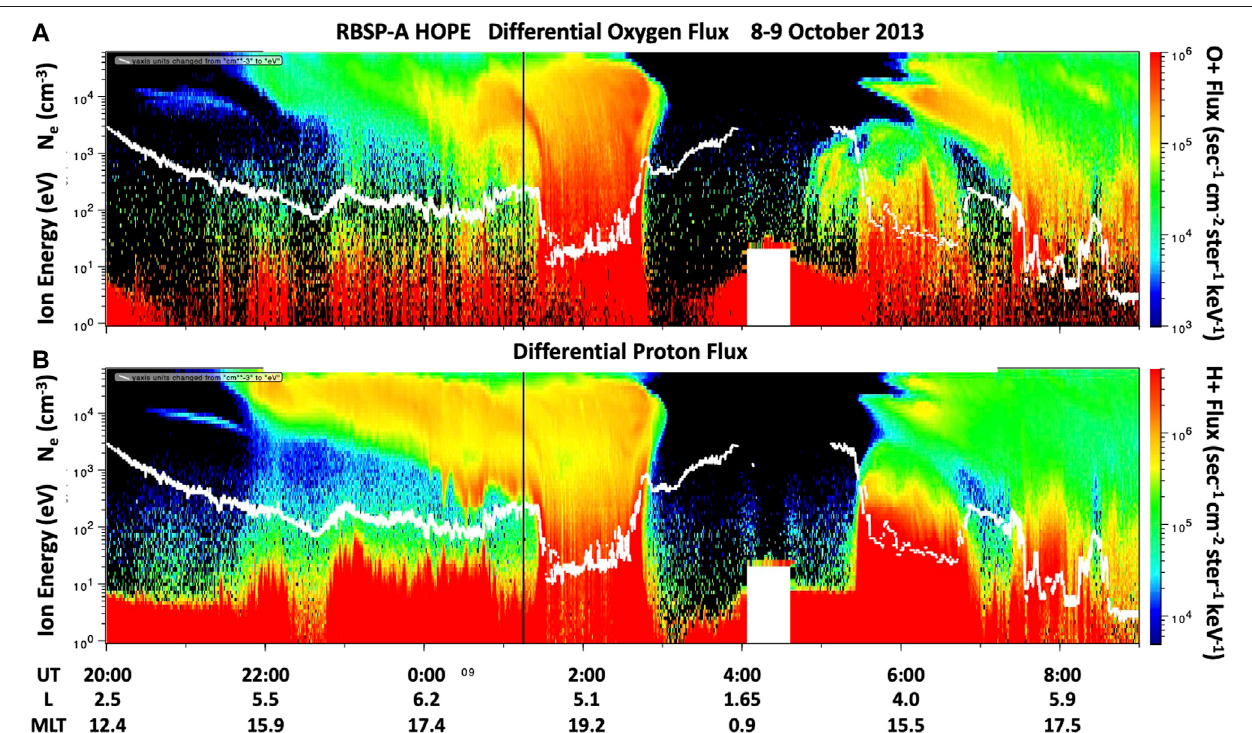
FIGURE 5 | RBSP-A oxygen (A) and proton (B) ion differential fl ux spectra are shown for an 8 – October 9, 2013 pass following an orbital trajectory (not shown) similar to that shown in Figure 2 . In situ plasma density derived from EMFISIS observations is superimposed as the white curves. RBSP-A traversed the outer region of the evening sector plume from 23:00 to 01:30 UT (apogee at 23:40 UT at 17 MLT). After exiting the plume at ∼ 01:30 UT (L ∼ 5.3, 18.5 MLT), the plasmasphere was reentered at ∼ 05:30 UT (L (cid:2) 3.2, 14.6 MLT). Black vertical lines indicate the times of plume O+ and H+ PADs shown in Figure 6 .